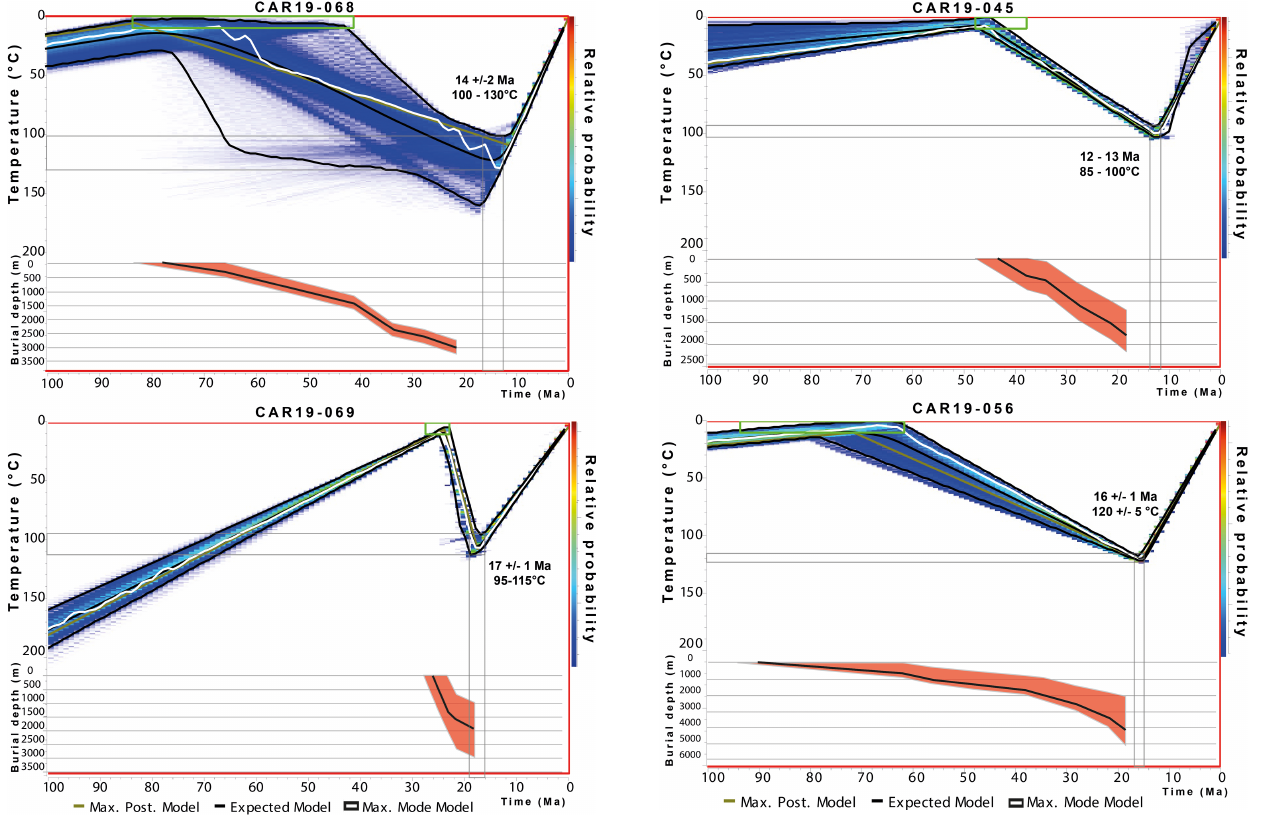
Figure 8. Modeled thermal histories and associated burial dia- grams for samples CAR19-068 and CAR19-069 from the Dukla and Krosno nappe, respectively. Peak burial temperature and time are highlighted by grey boxes.